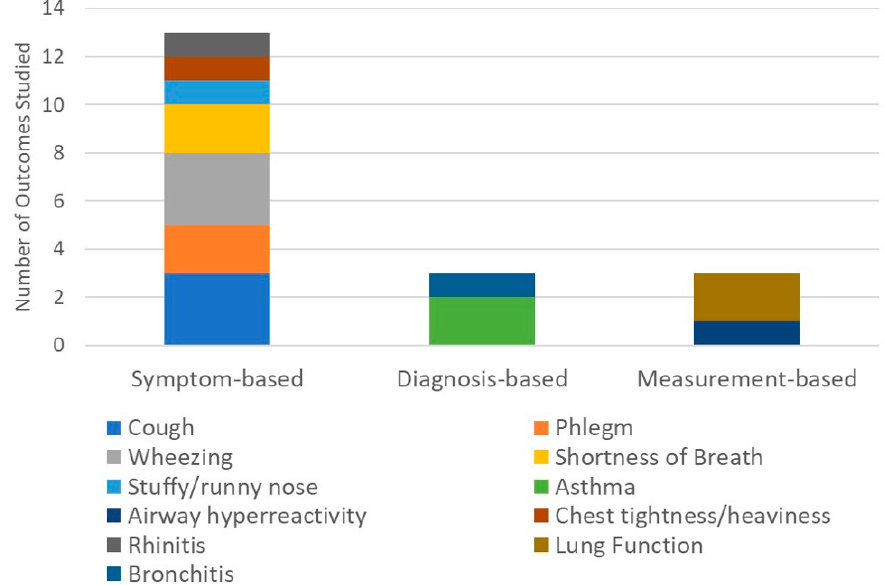
Figure 4. Distribution of types of respiratory outcomes examined for those classified as respiratory